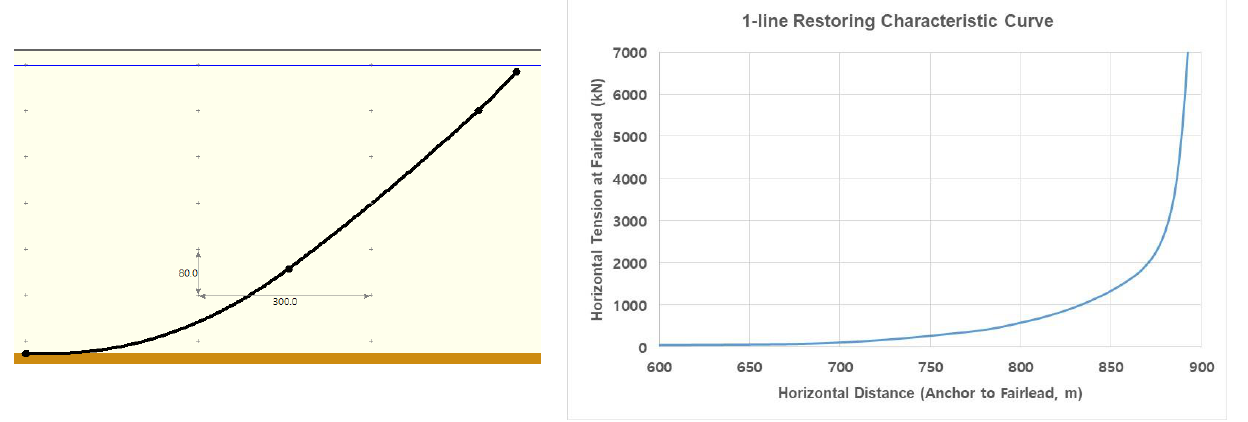
Figure 10. Optimized mooring line configuration ( left ) and its line characteristic ( right ). Table 11. The results of mooring the system optimization for case C.